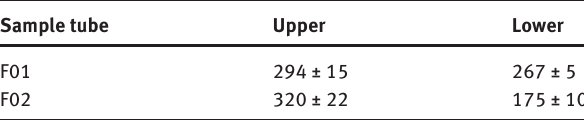
Table 14: Ultimate tensile strength values from test results performed at room temperature on supplied materials. For reference materials, data supplied by manufacturer have been used [32].